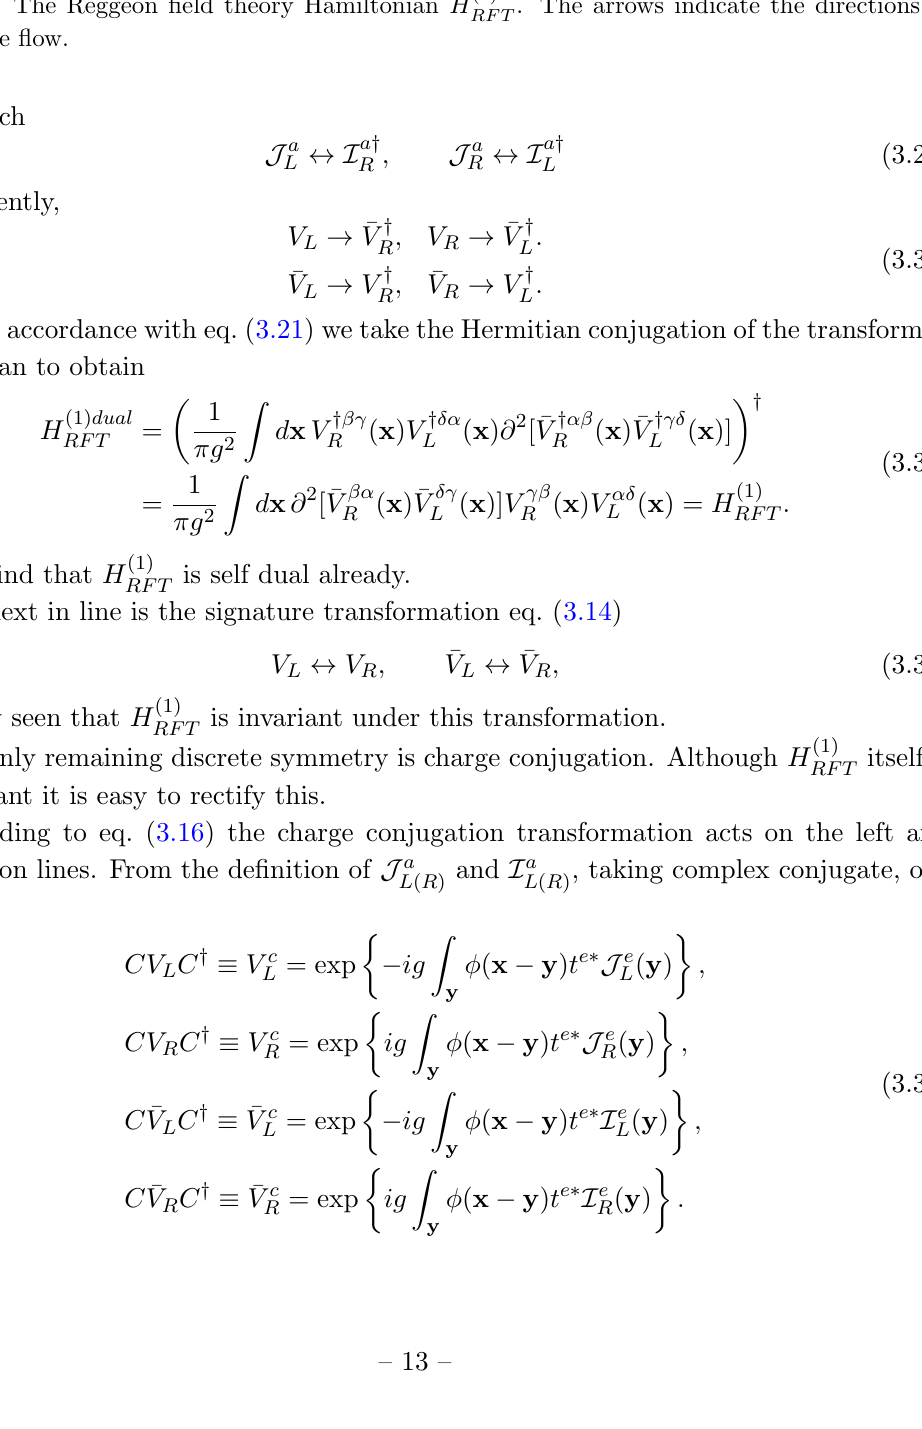
. The arrows indicate the directions of RFT